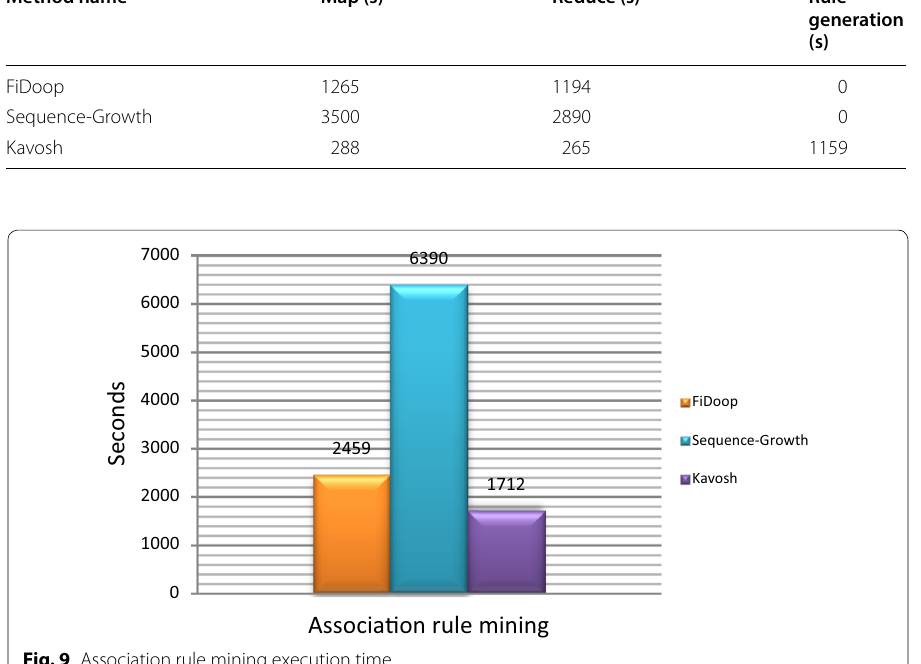
Fig. 9 Association rule mining execution